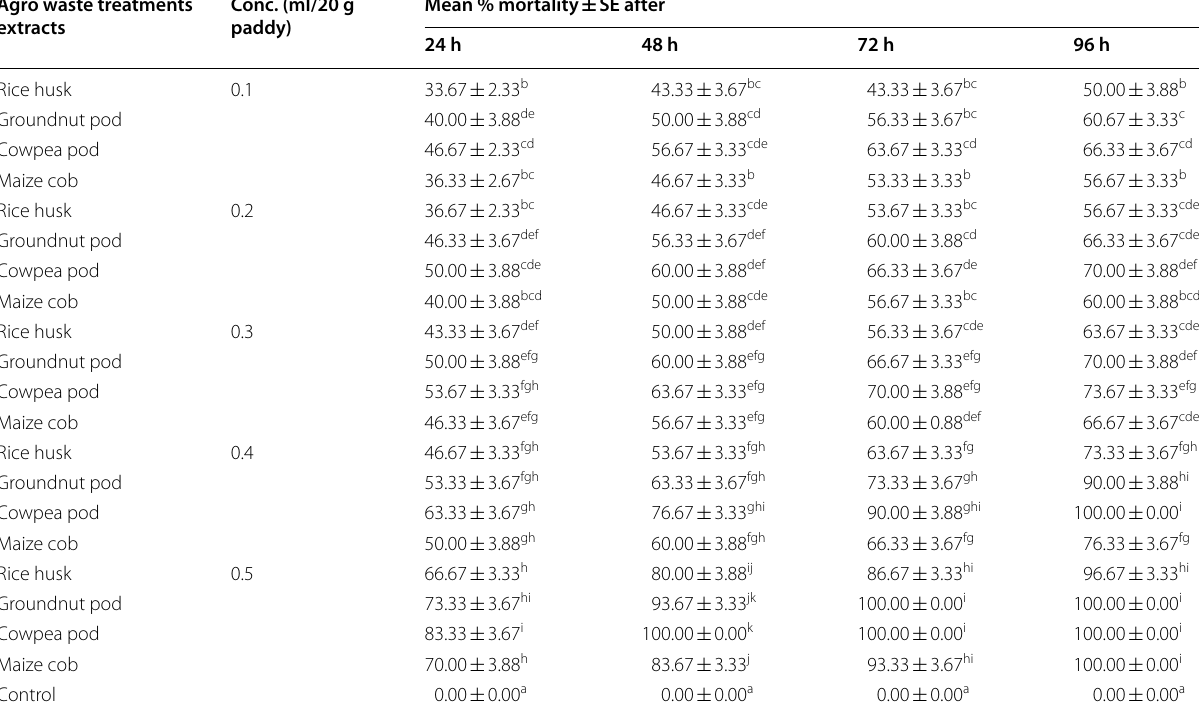
Mean followed by the same letters within the same column are not significantly different ( p > 0.05)